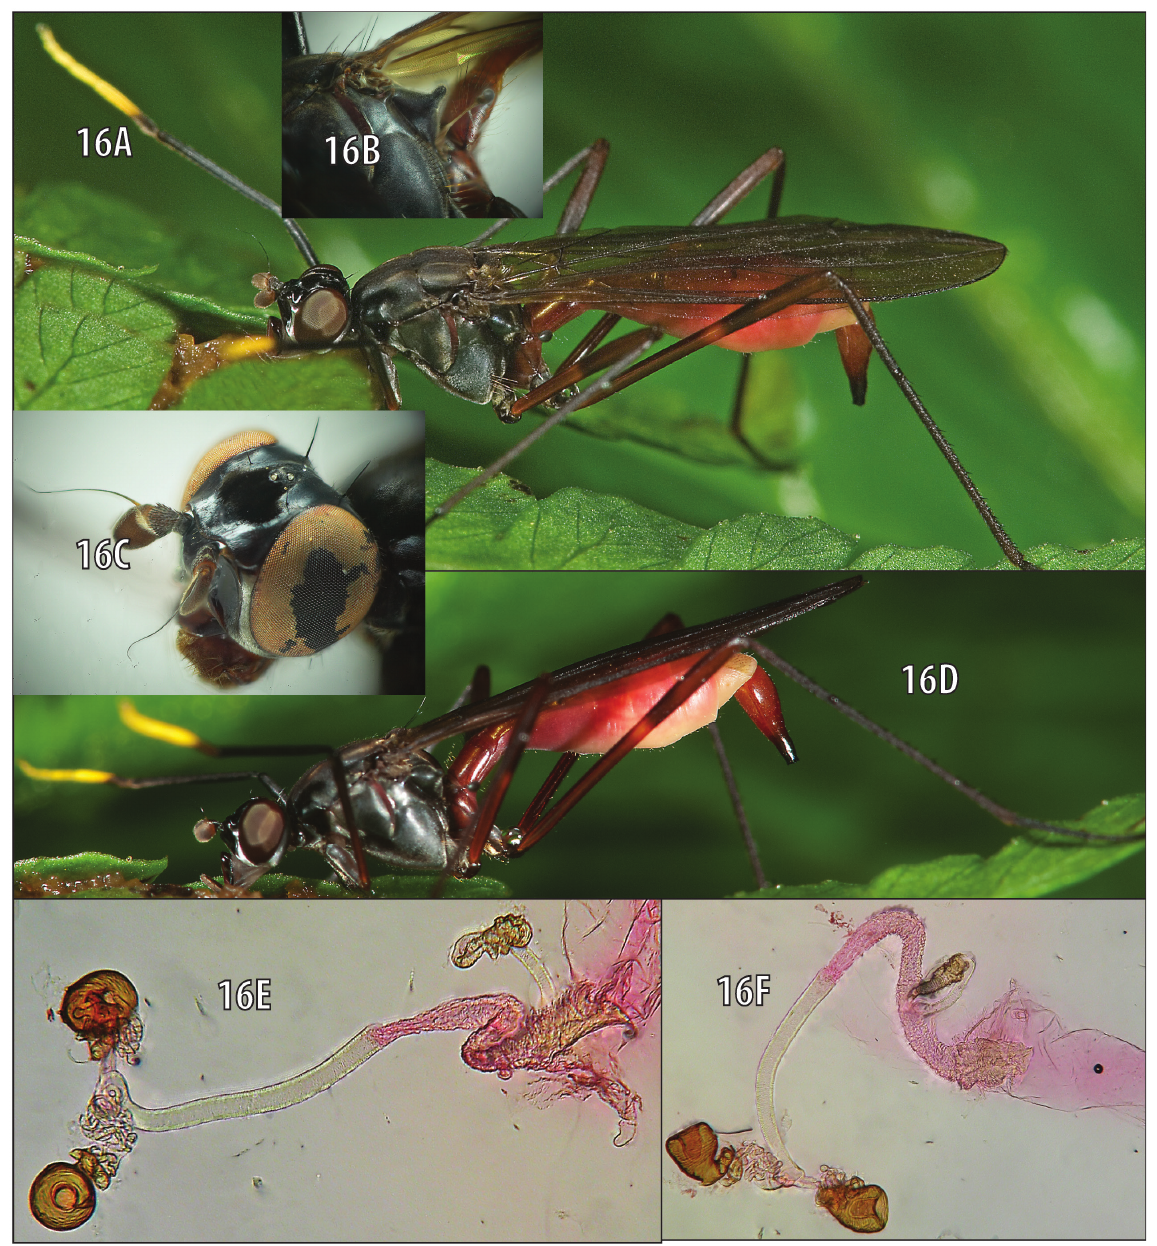
Fig. 16. Mesoconius rufipleuron sp. nov . A , D . Living ♀♀ in nature. B . Pleuron, to show katatergite. C . Head of paratype. E–F . Spermathecae and associated structures, lateral and dorsal